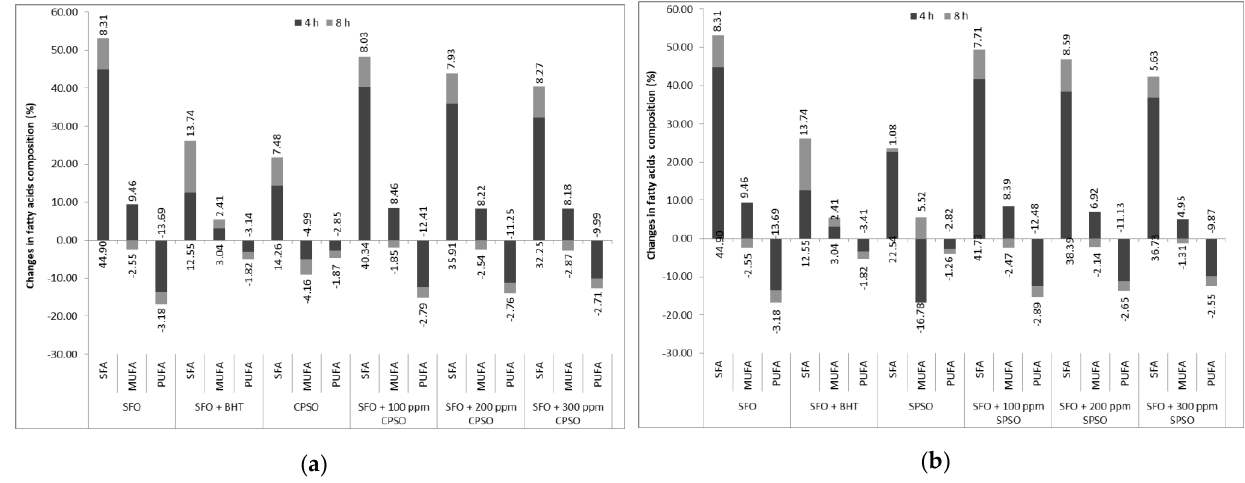
Figure 1. Changes in fatty acid composition of oil samples in response to heat treatment versus SFO sample. ( a ) CPSO; ( b ) SPSO.